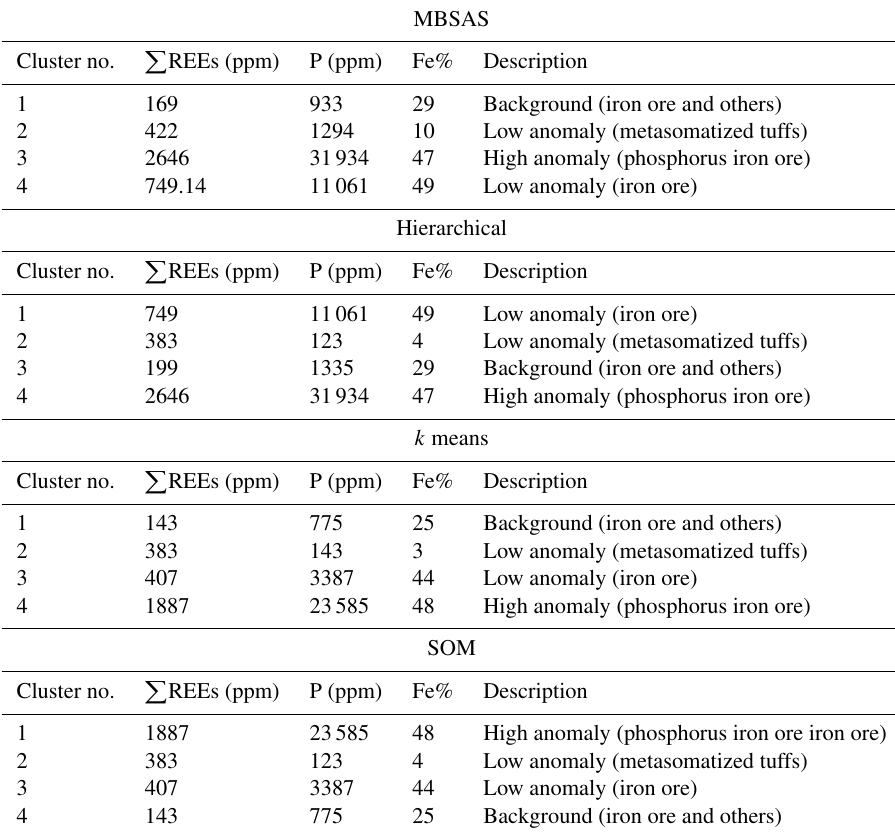
Table 2. Characteristics of each cluster in each method. Iron and phosphorus concentrations are shown for comparison.